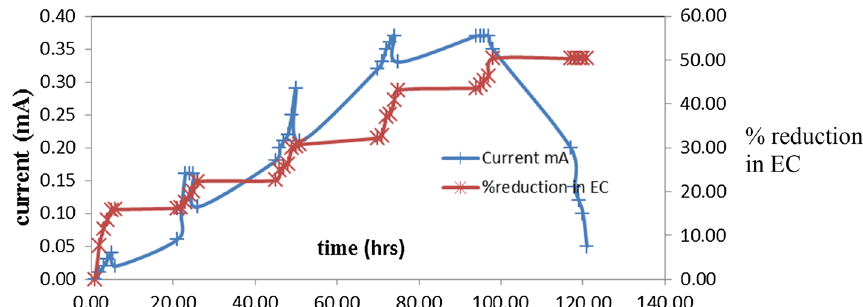
Fig. 4 Current versus percent- age reduction in EC